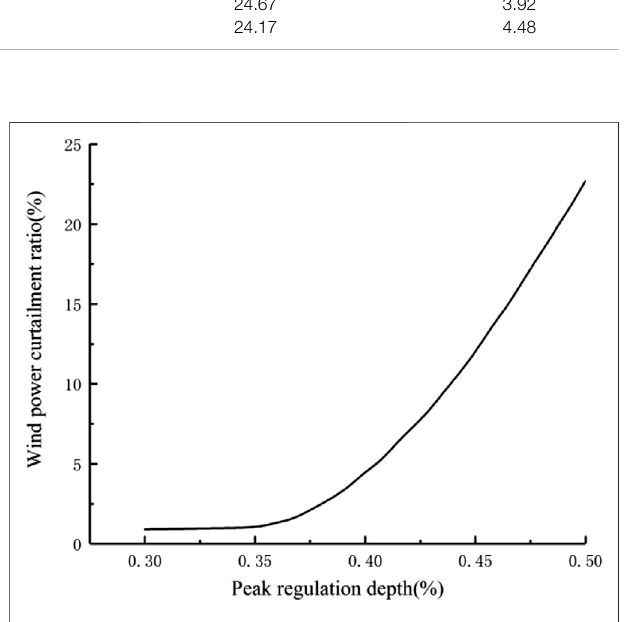
FIGURE 7 | Wind power curtailment ratio with different transmission power limit of tie-line.